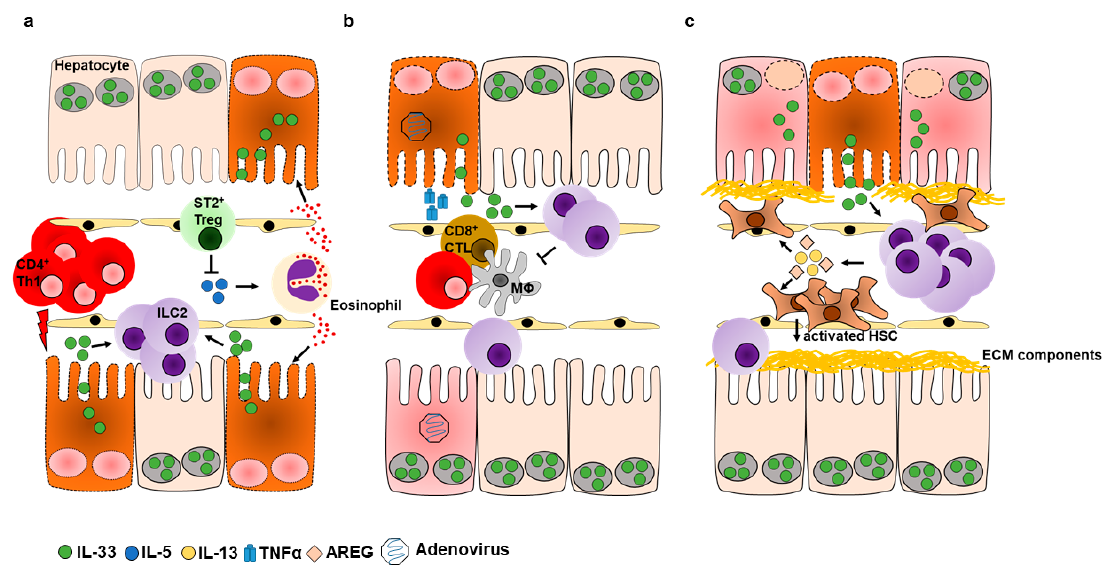
Figure 3. ILC2s have a paradoxical role during acute liver inflammation and promote hepatic fibrogenesis in response to chronic liver injury. ( a ) hepatic ILC2s expand in response to hepatocyte-derived IL-33 during acute immune-mediated hepatitis and amplify inflammation by IL-5-dependent recruitment of eosinophils. Exacerbated necrosis of hepatocytes and ongoing IL-33-release during acute inflammation induces IL-33-responsive Tregs that might limit the activity of ILC2s. ( b ) Adenoviral infection induces TNF α in anti-viral macrophages (M Φ ), CD4 + Th1 cells, and CD8 + cytotoxic T lymphocytes (CTL), thereby promoting the release of IL-33 from dying hepatocytes and activation of ILC2s. Expanded ILC2s limit function of anti-viral immune cells to prevent enhanced loss of hepatic tissue. ( c ) Ongoing necrosis in response to chronic liver injury renders constitutive activation of hepatic ILC2s to release IL-13 and AREG, which activate hepatic stellate cells (HSCs). Following activation, HSCs transform into myofibroblasts that promote liver fibrosis by depositing extra-cellular matrix (ECM) components.